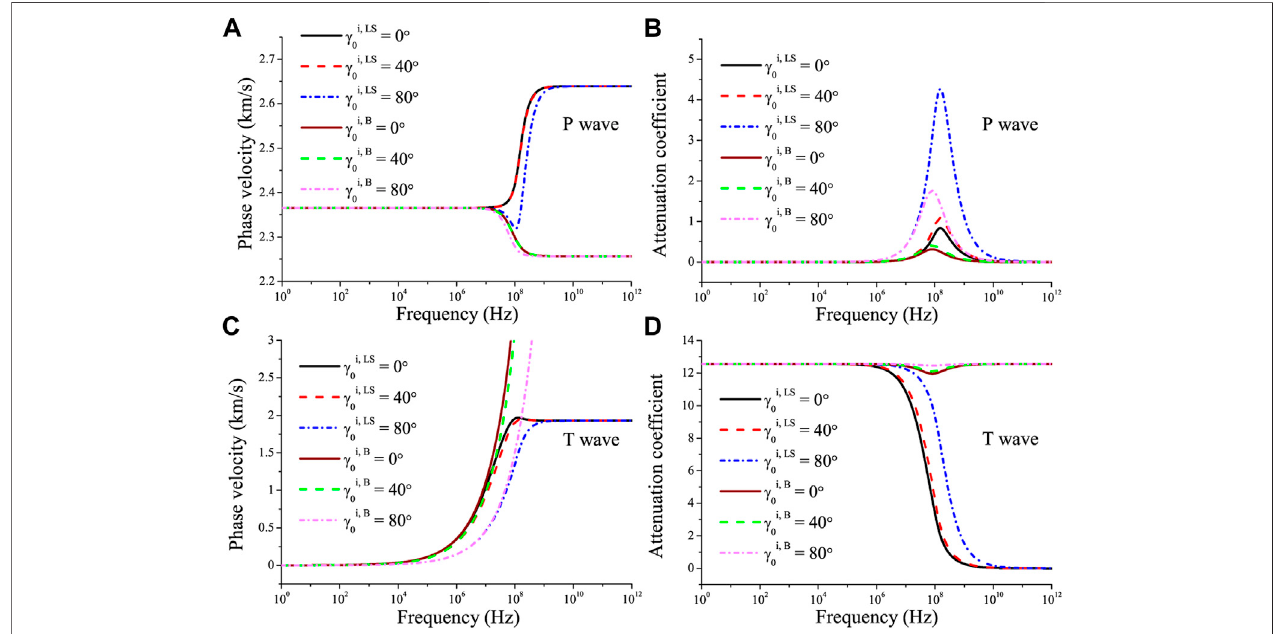
FIGURE 2 | Phase velocity and attenuation coef fi cients of the P wave (A,B) and T wave (C,D) as a function of frequency in the incidence medium with different γ 0 . The superscripts LS and B represent the Lord-Shulman and classical-Biot theories, respectively.